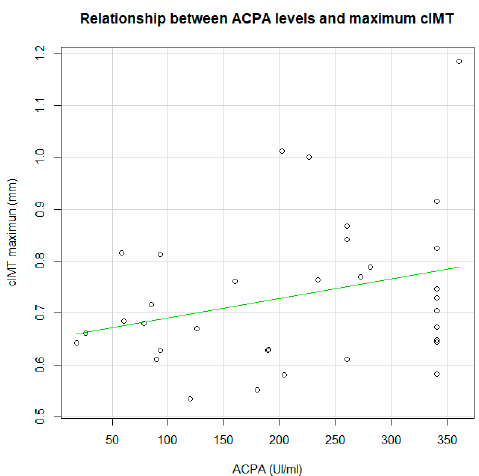
Figure 1. Correlation between anti-citrullinated peptide antibodies (ACPA)titters and carotid intima media thickness (cIMT) maximum.